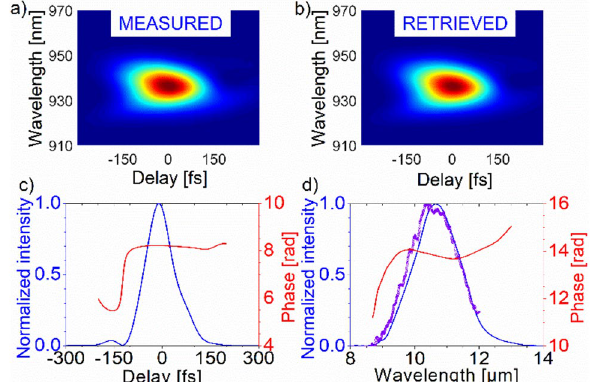
Figure 5. ( a ) Measured and ( b ) reconstructed X-FROG traces obtained for chirp-compensated idler pulses. Retrieved temporal ( c ) and spectral ( d ) intensity and phase. The retrieved pulse duration is 101 fs. The symbols in ( d ) represent the measured spectrum.